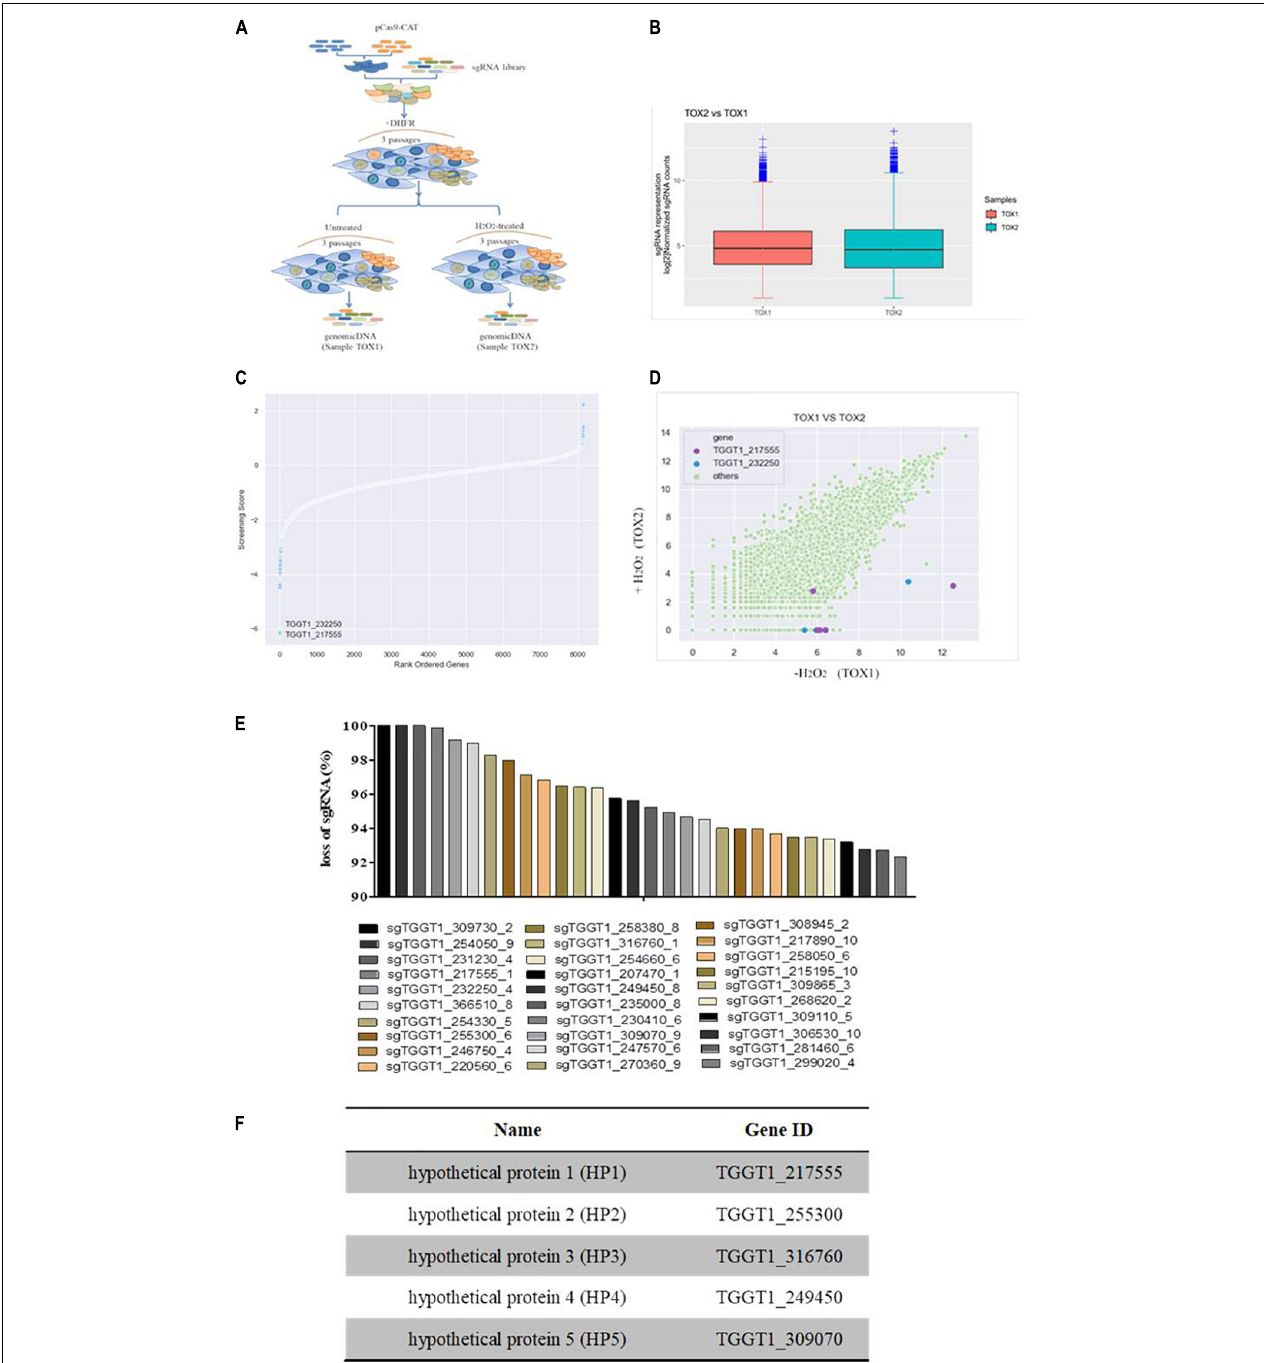
FIGURE 2 | Genome-wide screen identifies mutants hypersensitive to H 2 O 2 . (A) Workflow of the genome-wide screen. RH/Cas9 parasites were transfected with a library of sgRNAs. Transfected parasites were grown in Vero cells and selected by pyrimethamine. Subsequently, the mutants were either treated with H 2 O 2 for three passages or continuously passaged in Vero cells. SgRNA was sequenced and analyzed to select genes related to H 2 O 2 sensitivity. (B) Boxplot showing the distribution of sgRNA frequencies before and after H 2 O 2 treatment. (C) Toxoplasma gondii genes were ordered according to their screening scores, which is defined as the mean log 2 -fold-change of the top five most abundant sgRNA for each gene in the control sample. A lower score indicates that the sensitivity of mutants to H 2 O 2 increases when the gene is deleted. Guides against TGGT1_217555 and CAT were significantly depleted upon H 2 O 2 treatment. (D) Scatter plots representing the relative abundance of sgRNAs in the untreated sample and H 2 O 2 -treated sample; sgRNAs against TGGT1_232250 (blue); sgRNAs against TGGT1_217555 (purple). (E) The top 30 candidate genes were selected according to the percentage of lost sgRNA. (F) List of selected putative antioxidant genes numbered according to the percentage of lost sgRNA from highest ( HP1 ) to lowest ( HP5 ).